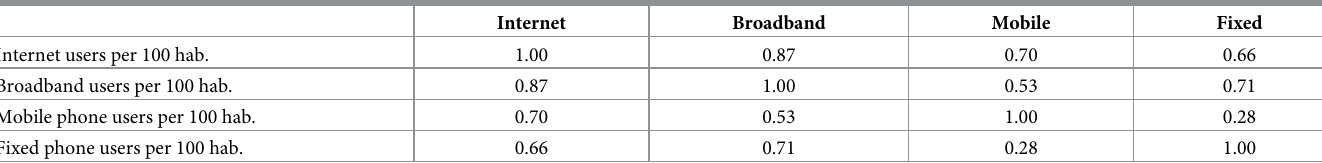
As Table 3 indicates, although there some rather strong correlations among these variables, mobile phone penetration appears to have a distinct character from its fixed phone counter- part: their correlation coefficient is only 0.445. This probably highlights the different composi- tion of the population or infrastructure development patterns in the developing world, where mobile telephony helped overcome the lack of fixed line infrastructure and mobile phone net- works are also used as the main way to use the internet [54, 55]. The availability of a panel dataset for city sizes across countries enables us to use country fixed effects, which can address potential endogeneity issues related to unobserved country specific characteristics of city size distributions. However, such a strategy does not address potential simultaneity issues. Simply put, internet penetration might be affected by spatial structure, as reflected in Pareto exponents, or both internet penetration and spatial structure might be jointly determined by a third variable. E.g., if a country already has a dispersed spatial structure, internet is particularly suitable in facilitating communication. Potential endogeneity Table 3. Correlations between ICT variables.